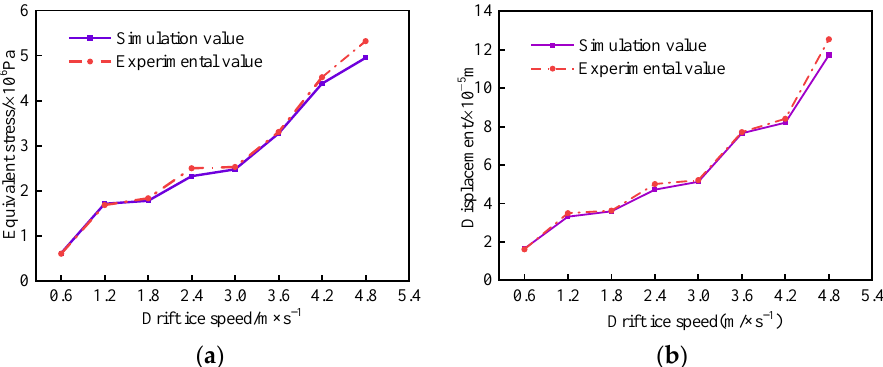
Figure 4. Comparison of simulation and experimental results of different drift ice speeds. ( a ) Maxi- mum equivalent stress; ( b ) maximum displacement in X -direction. mum equivalent stress; ( b ) maximum displacement in X